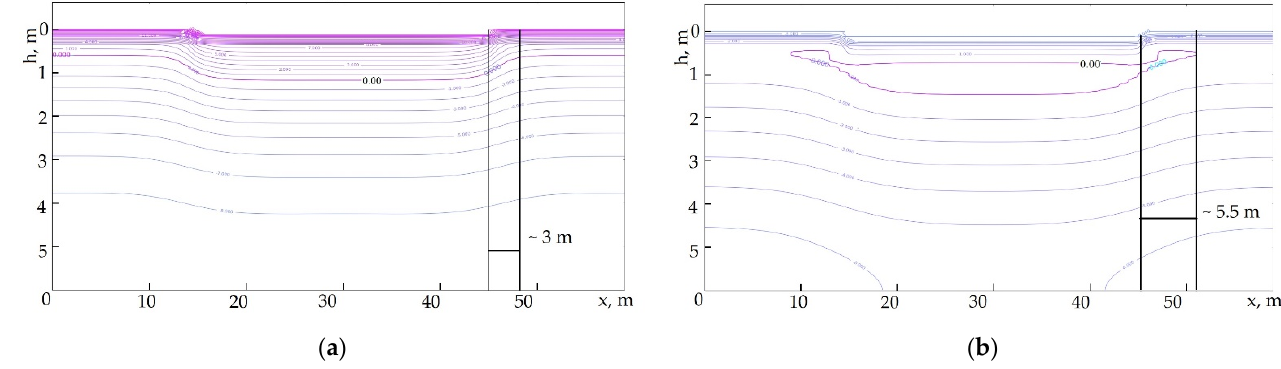
Figure 7. Results of numerical modeling of a two-dimensional temperature field (° С ) for 200th day ( a ) and for 294th day ( b ).